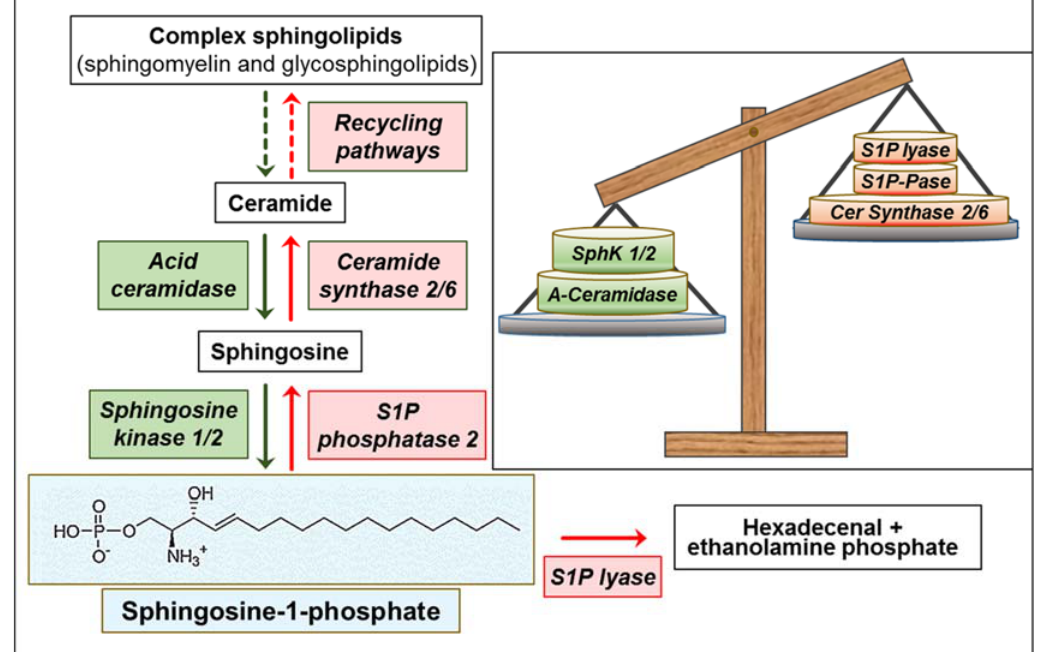
Figure 1. Overview of sphingosine ‐ 1 ‐ phosphate (S1P) metabolism and its alterations in glioblastoma (GBM). Green: overexpressed/upregulated enzymes; red: downregulated enzymes. Green and red arrows, increased and decreased enzyme activity, respectively. The insert shows the imbalance between enzymes involved in S1P formation (green) and degradation (red).